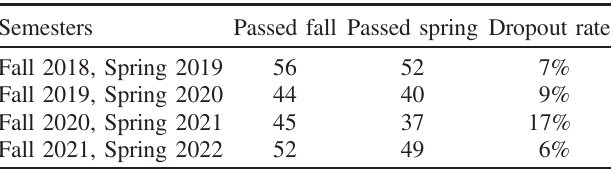
TABLE II. Number of physics majors who passed the Intro- duction courses in the fall and in the spring and the dropout